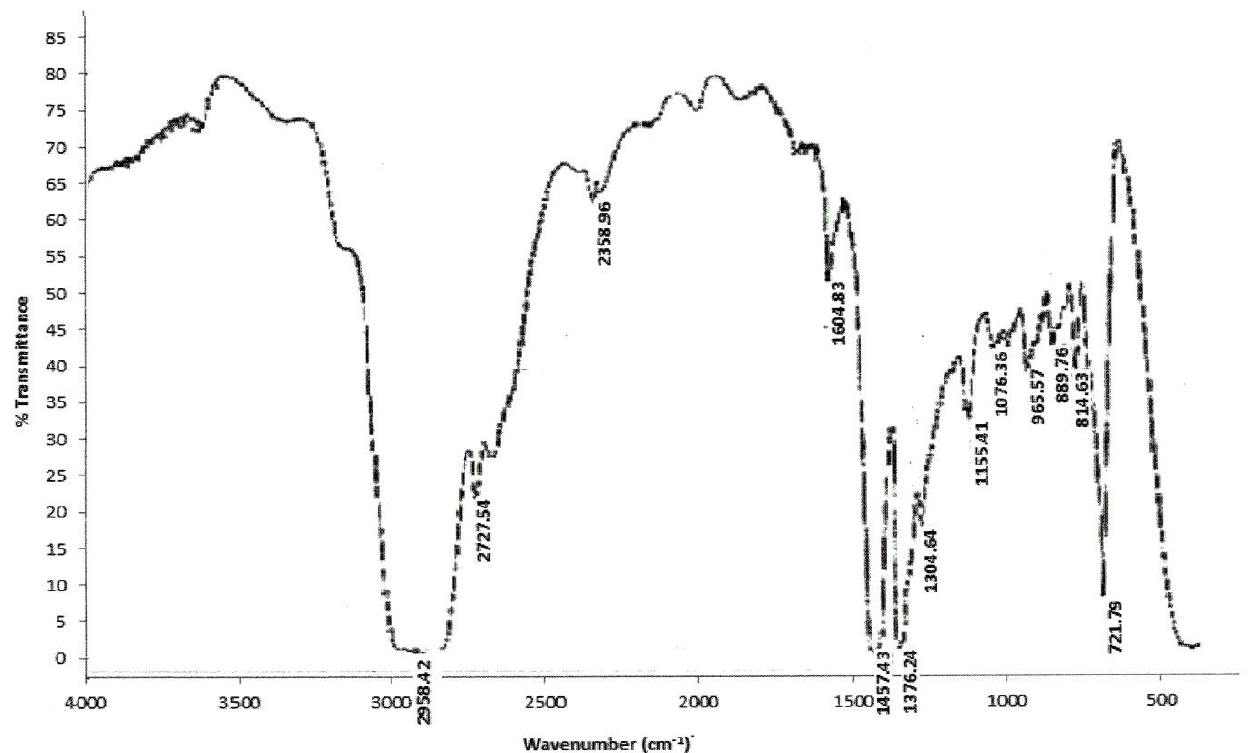
Figure 5. Results of analysis of the recycled oil (after adding the additives) by acid-clay method in local companies in Kurdistan/Iraq.